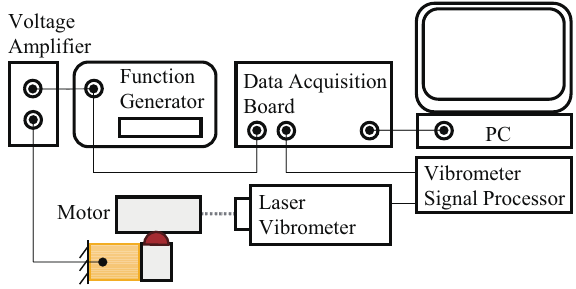
Figure 7. Schematic control graph of the experimental setup.